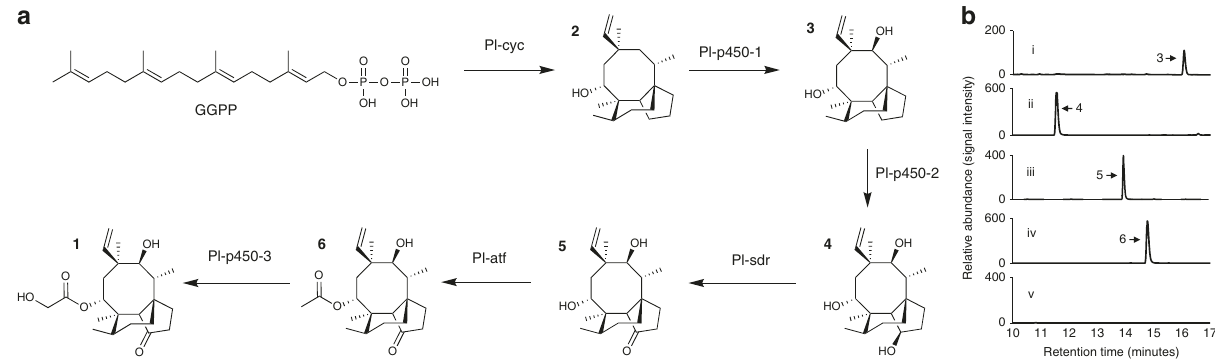
Fig. 4 De novo production of pleuromutilin intermediates. a Proposed biosynthetic pathway to 1 in Clitopilus passeckerianus . b HPLC chromatograms showing de novo production of pleuromutilin intermediates in Aspergillus oryzae strains. (i) A. oryzae GCP1, (ii) A. oryzae GCP1P2, (iii) A. oryzae GCP1P2S, (iv) A. oryzae GCP1P2SA and (v) A. oryzae NSAR1 (recipient strain). Traces were recorded with evaporative light scattering